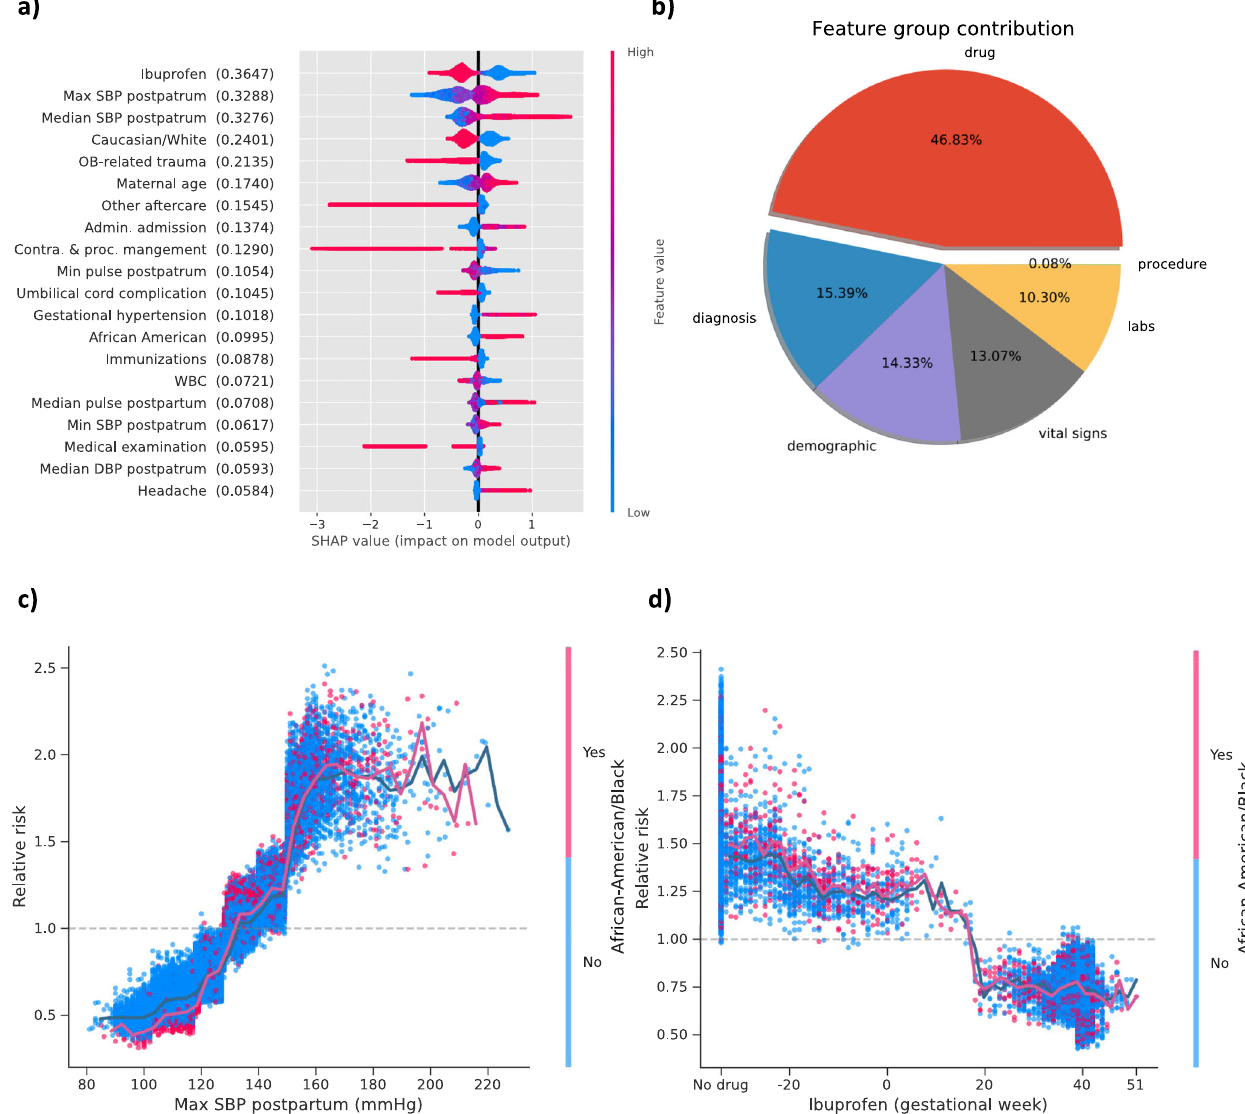
Fig. 6 Feature inspection for postpartum based on SHAP value. a SHAP summary plot for top 20 features. Features in the summary plot ( Y - axis) are ordered by the mean absolute SHAP values (in the parenthesis after each feature name), representing the importance of the feature in driving the postpartum PE prediction. Values of the feature for each patient are colored by their relative value with red signifying high value and blue presenting low value. Positive SHAP values indicate increased risks for postpartum PE and negative values indicate protective effects to postpartum PE. b The average feature category contribution. c The dependence plot of PE relative risk in terms of maximum SBP measured in postpartum. d The dependence plot of PE relative risk versus ibuprofen. The SHAP dependence plots indicate how different values of the features can affect relative risks and ultimately impact classi fi er decision for SBP and ibuprofen strati fi ed by African American race. The solid line shows the mean of SHAP Supplementary Table 21. We evaluated performance in these two datasets using four predictive performance metrics, AUC, PPV (positive predictive value), NPV (negative predictive value), and speci fi city (SPE) (Fig. 7). Other detailed metrics are reported in Supplementary Tables 22 – 23.